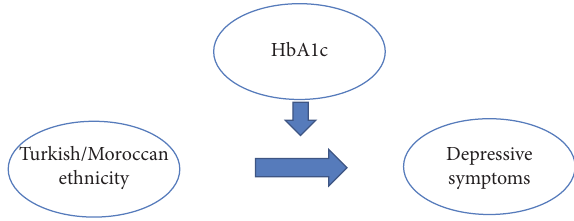
Figure 2: The interaction effect between Moroccan and Turkish ethnicity, HbA1c, and depressive